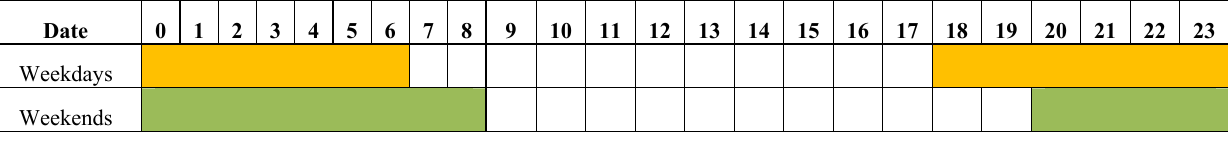
Figure 2. Daily occupation period of building (00:00–23:00) (colored indicates that the house is